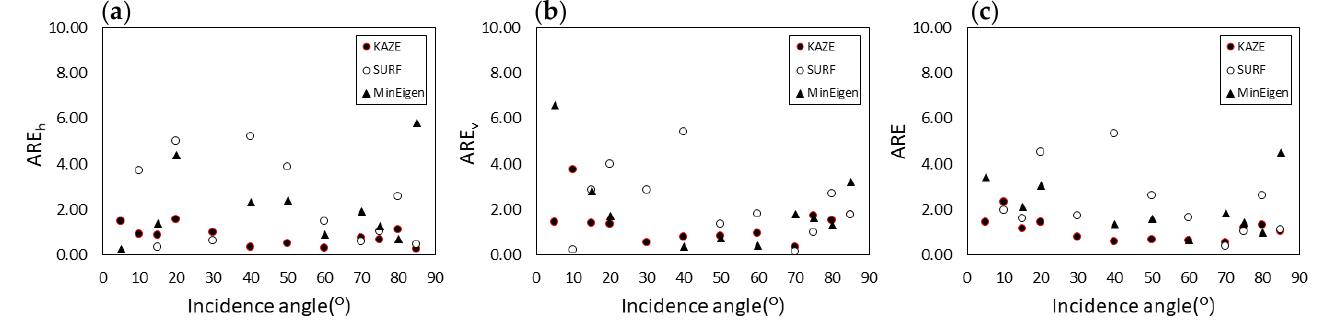
Figure 10. Distribution of ARE h , ARE v , and ARE with different feature matching methods at com- bined displacement. ( a ) ARE h ; ( b ) ARE v ; ( c ) ARE.